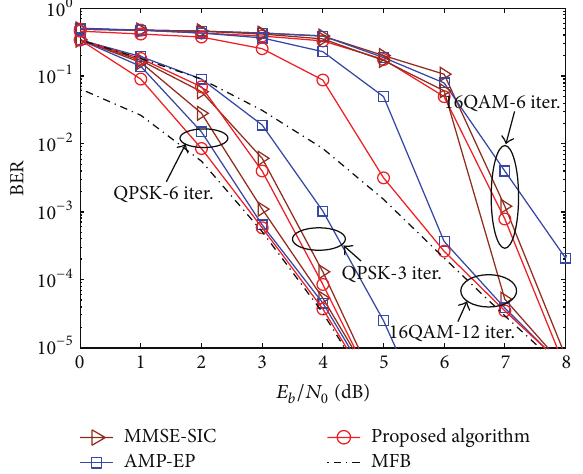
Figure 5: BER performance for different detection algorithms in a 64 × 64 MIMO system, with QPSK and 16QAM modulation, 16-tap Rayleigh channel with equal tap power.